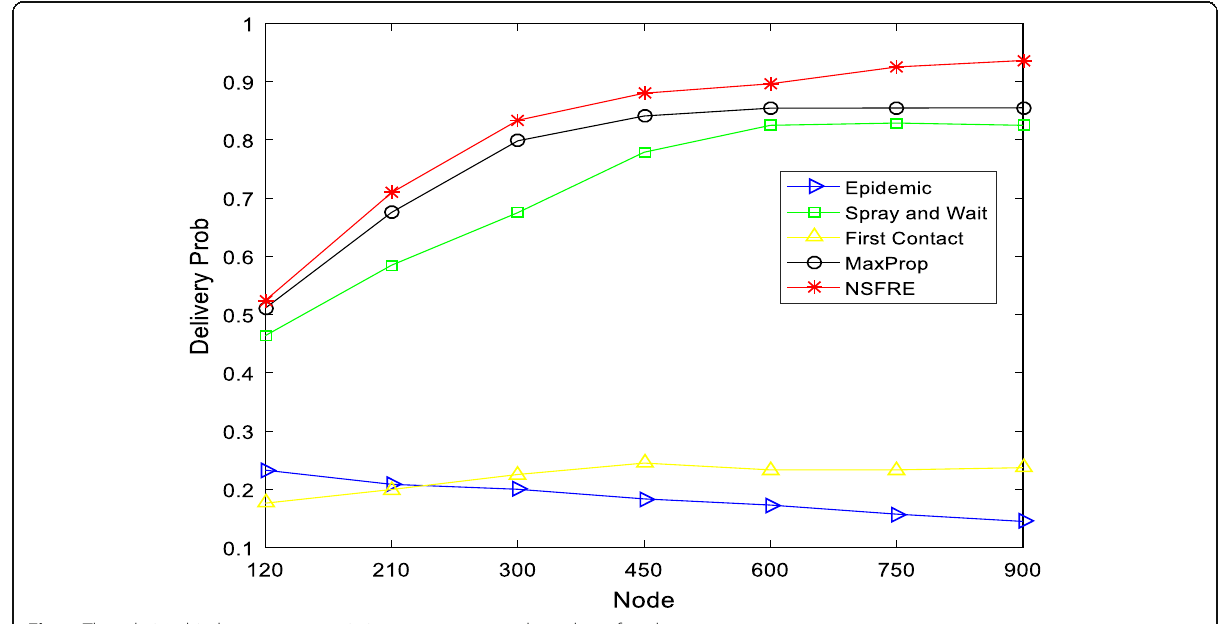
Fig. 7 The relationship between transmission success rate and number of